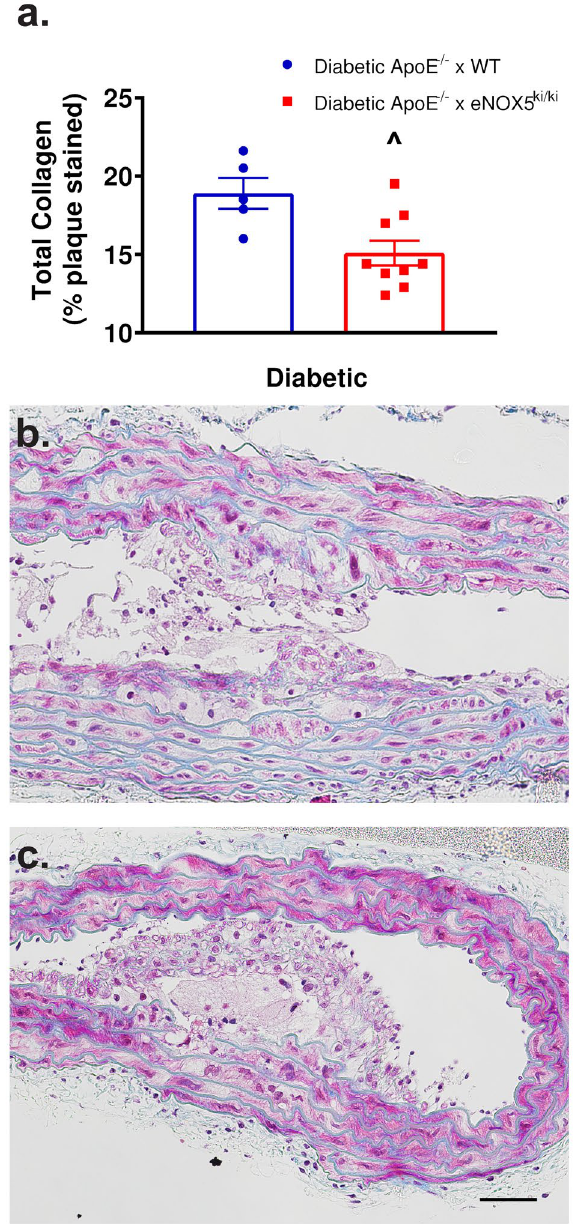
Figure 4. Endothelial Nox5 expression results in lower vascular collagen accumulation in diabetic eNOX5 ki/ki ApoE −/− mice ( a ). Quantification of trichrome staining in the atherosclerotic plaque and underlying vessel wall of diabetic ApoE −/− mice with ( b ) and without ( c ) eNOX5 expression. Assessment of the amount of blue collagen accumulation shows that diabetic animals expressing eNOX5 had significantly less collagen. Data shown as mean ± SEM of n = 6–9 animals/group. ^ Student’s t-test between diabetic groups p = 0.012. 50 μm scale